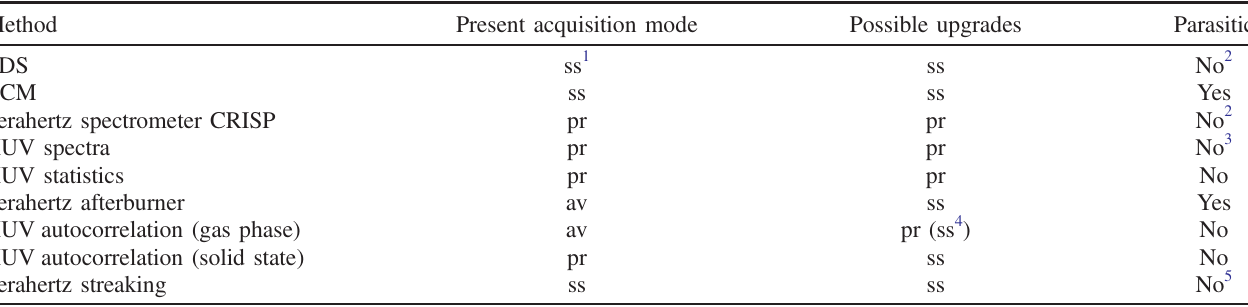
TABLE I. Summary of acquisition modes of the pulse duration measurement techniques used in the experimental campaign. ss: single shot, every pulse generated is measured; pr: averaging technique, able to deliver the (average) pulse duration on every pulse in the burst (pulse resolving); av: averaging over the burst and over many successive shots. Parasitic is defined in a way that the measurement is not disturbing the beam and can be done in parallel to a user